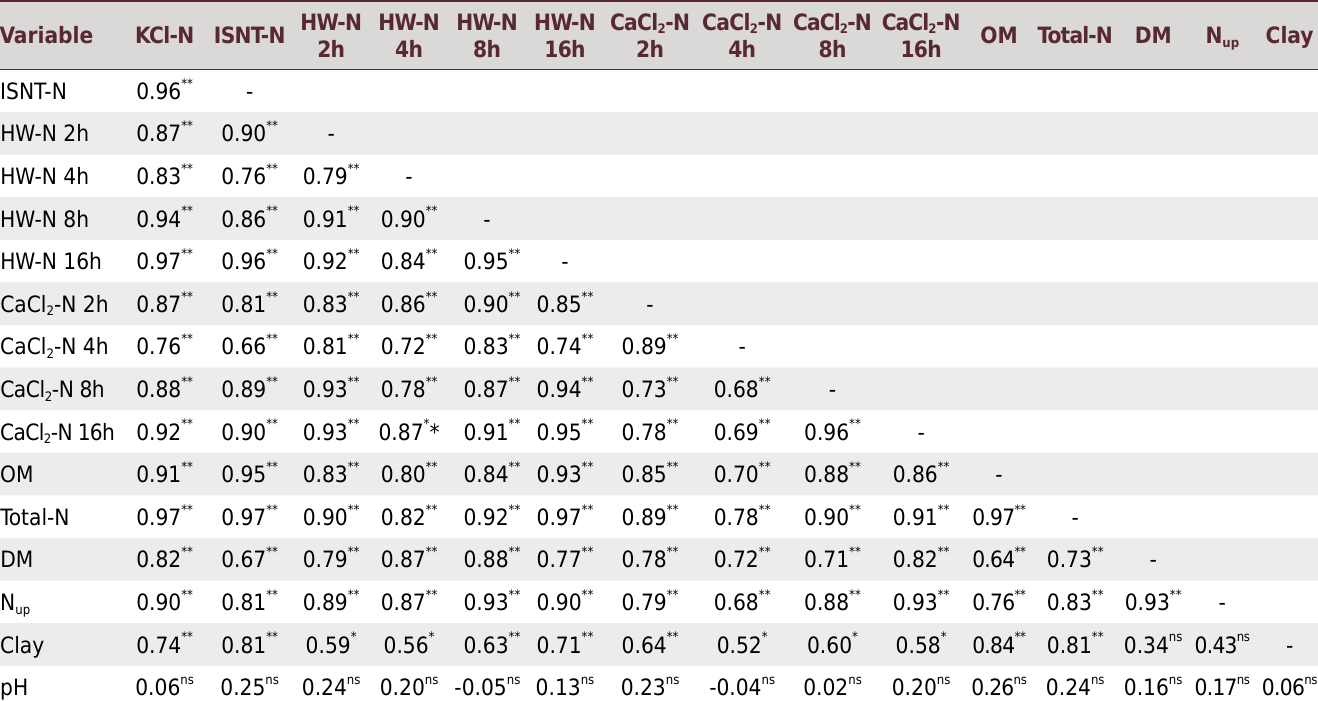
Table 3. Linear correlation coefficients (r) between the potentially available organic-N concentrations extracted by different extraction methods and plant dry matter production (DM), N uptake (N up ), soil organic matter (OM), soil total N, soil clay content, and pH